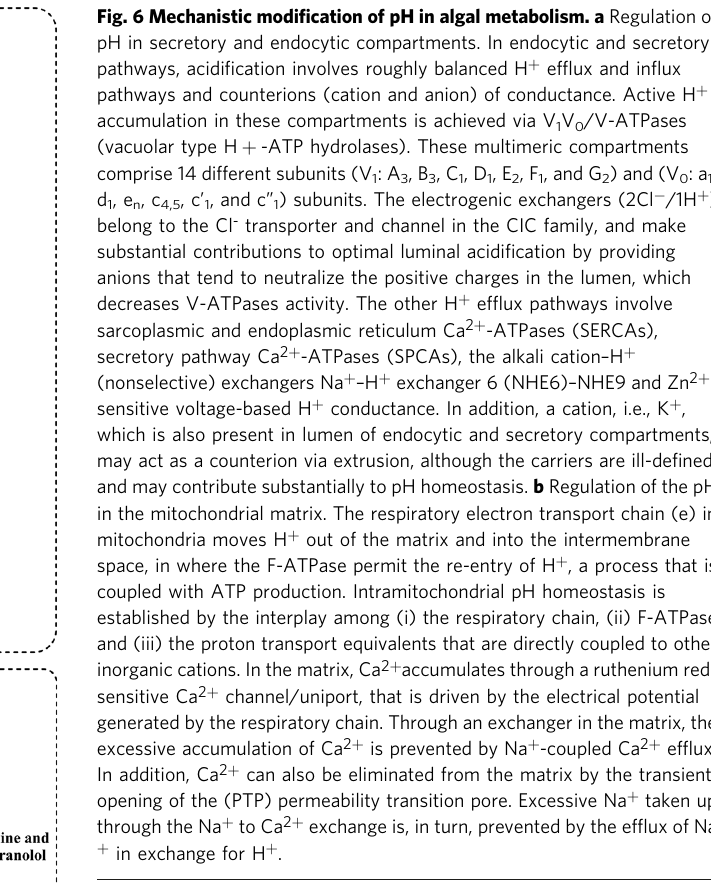
Fig. 6 Mechanistic modi fi cation of pH in algal metabolism. a Regulation of pH in secretory and endocytic compartments. In endocytic and secretory pathways, acidi fi cation involves roughly balanced H + ef fl ux and in fl ux pathways and counterions (cation and anion) of conductance. Active H + accumulation in these compartments is achieved via V 1 V 0 /V-ATPases (vacuolar type H + -ATP hydrolases). These multimeric compartments comprise 14 different subunits (V 1 : A 3 , B 3 , C 1 , D 1 , E 2 , F 1 , and G 2 ) and (V 0 : a 1 ,